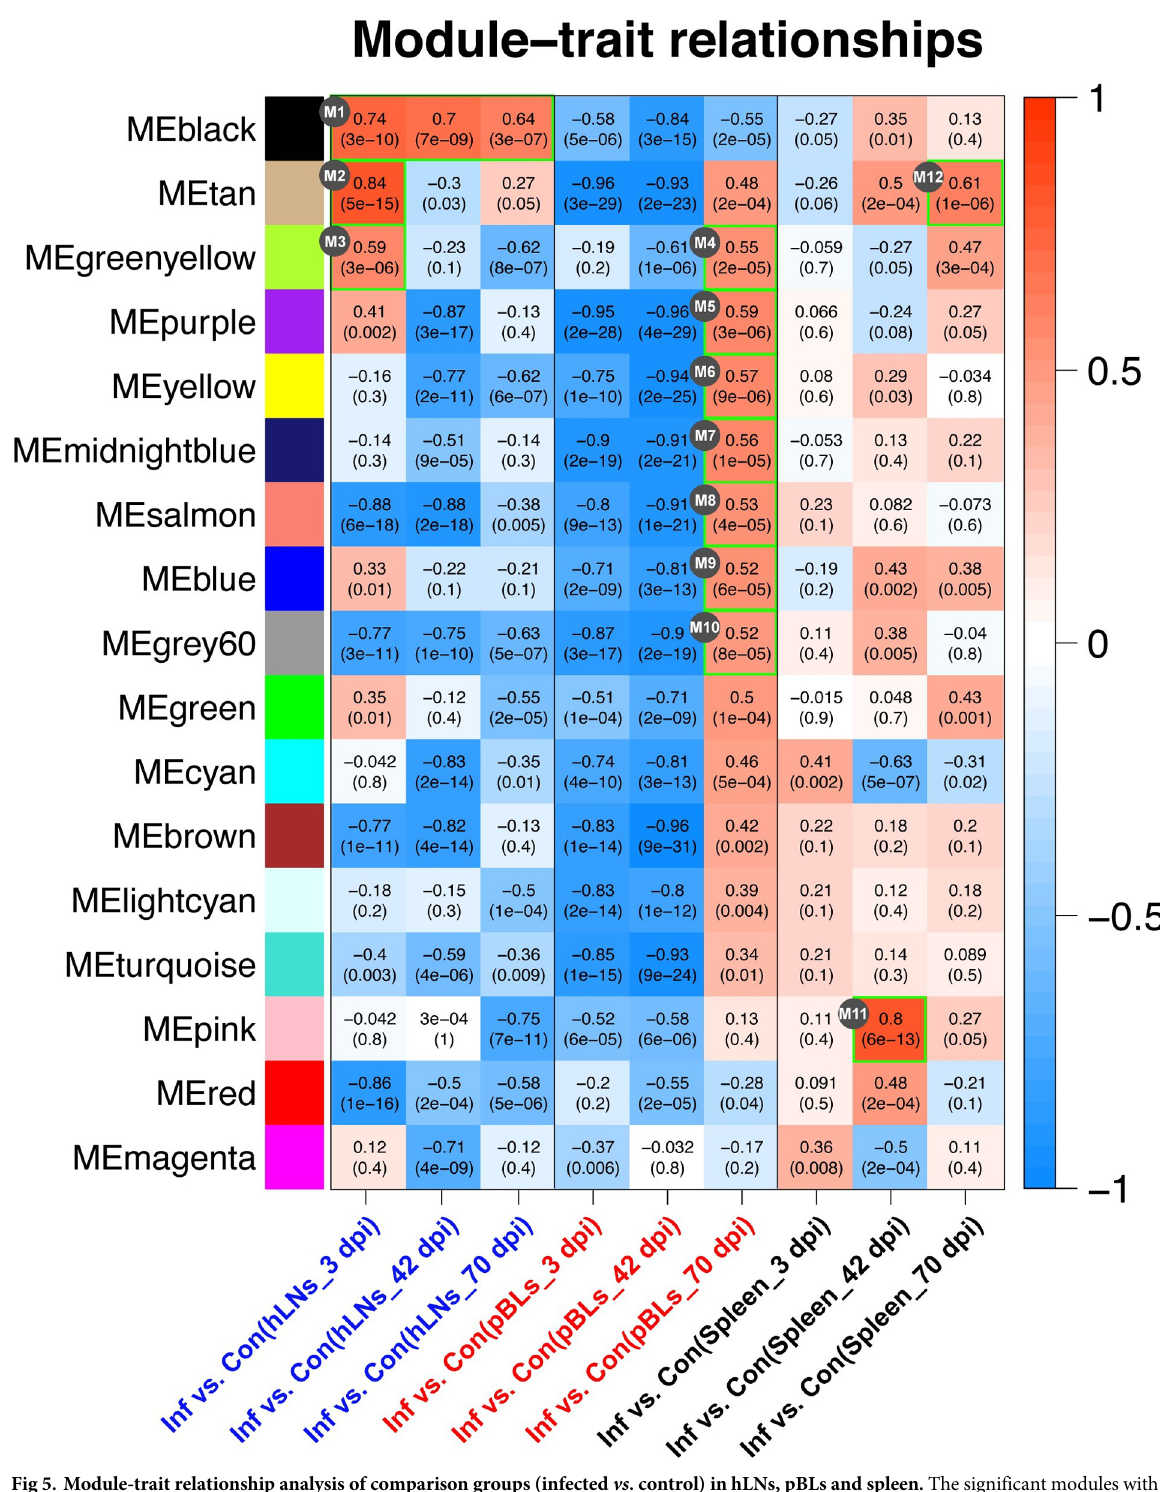
PLOS NeglectedTropical Diseases | https://doi.org/10.1371/journal.pntd.0010286 March 23,